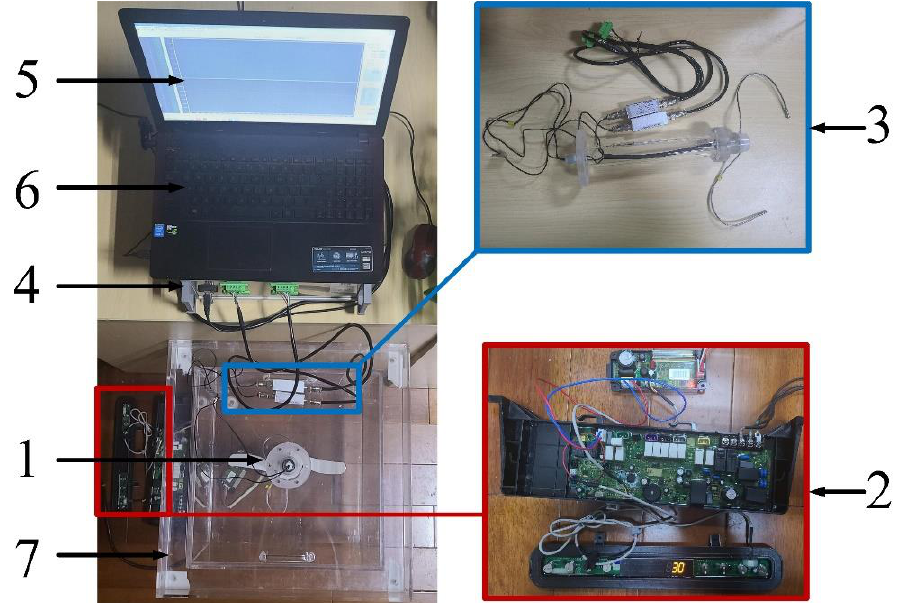
Figure 3. Dishwasher pump test system. 1: dishwasher pump, 2: impeller speed regulator, 3: rotating pressure pulsation test device, 4: data-acquisition system, 5: software interface, 6: personal computer, and 7: water tank.